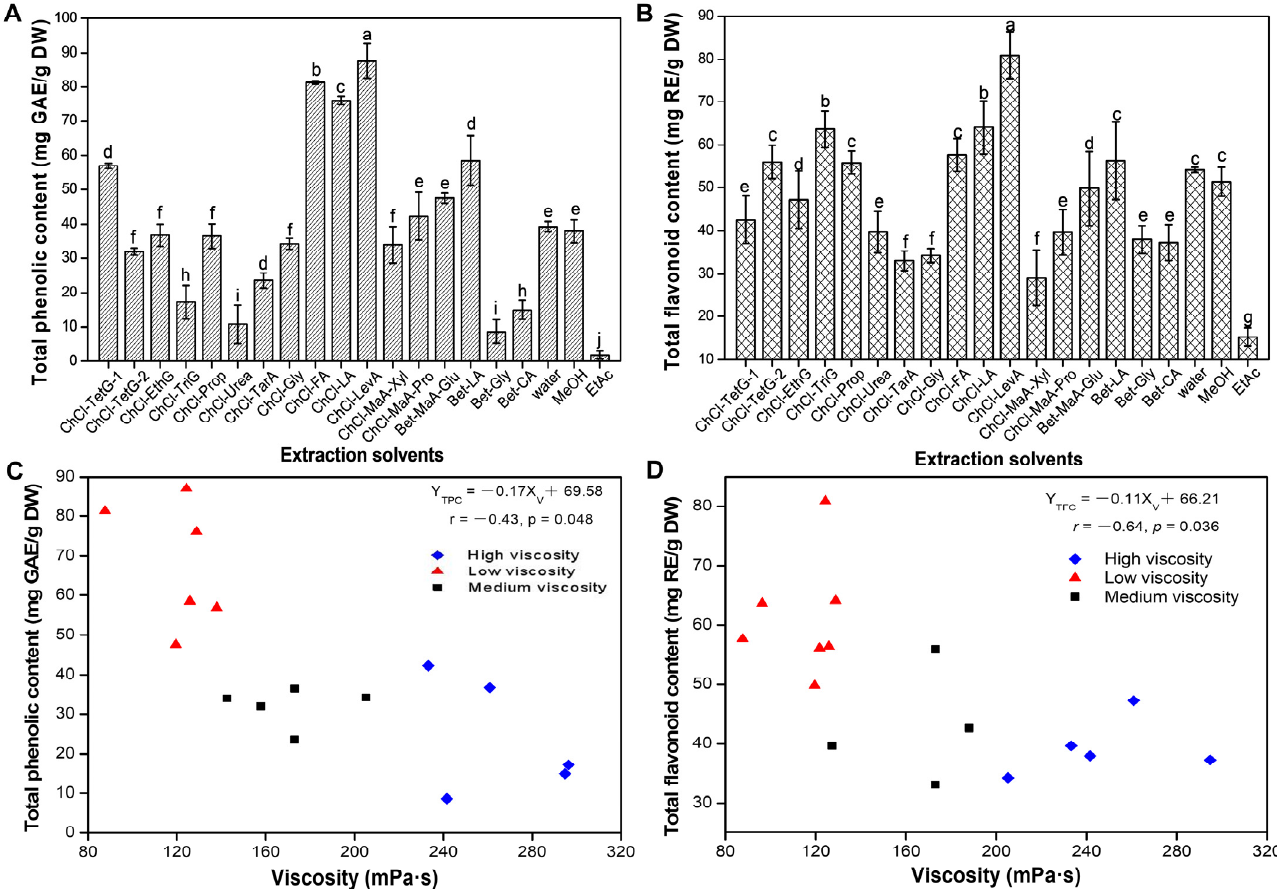
Figure 1. Total phenolic content (TPC, A ), total flavonoid content (TFC, B ) of dogbane leaf-tea (DLT) extracts extracted with various solvents; TPC or TFC of the DLT extracts versus viscosity of 17 types of DESs ( C , D ). Different lowercase letters indicate significant differences.